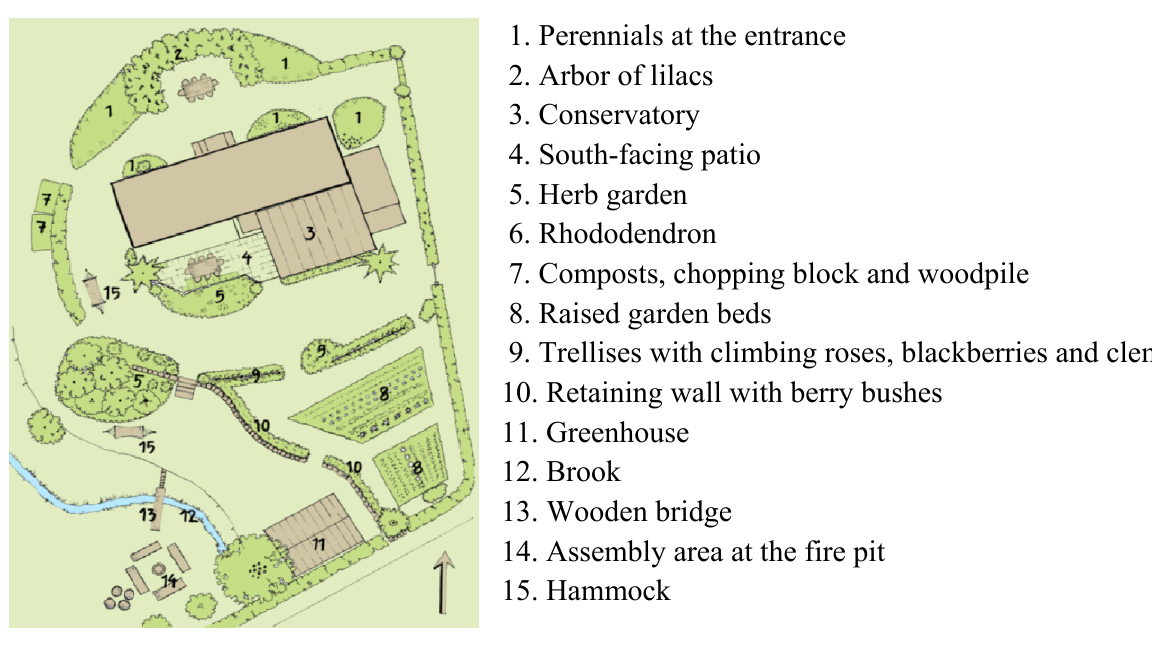
Figure 4. The Venue (Gröna Rehab, Gothenburg Botanical Garden).